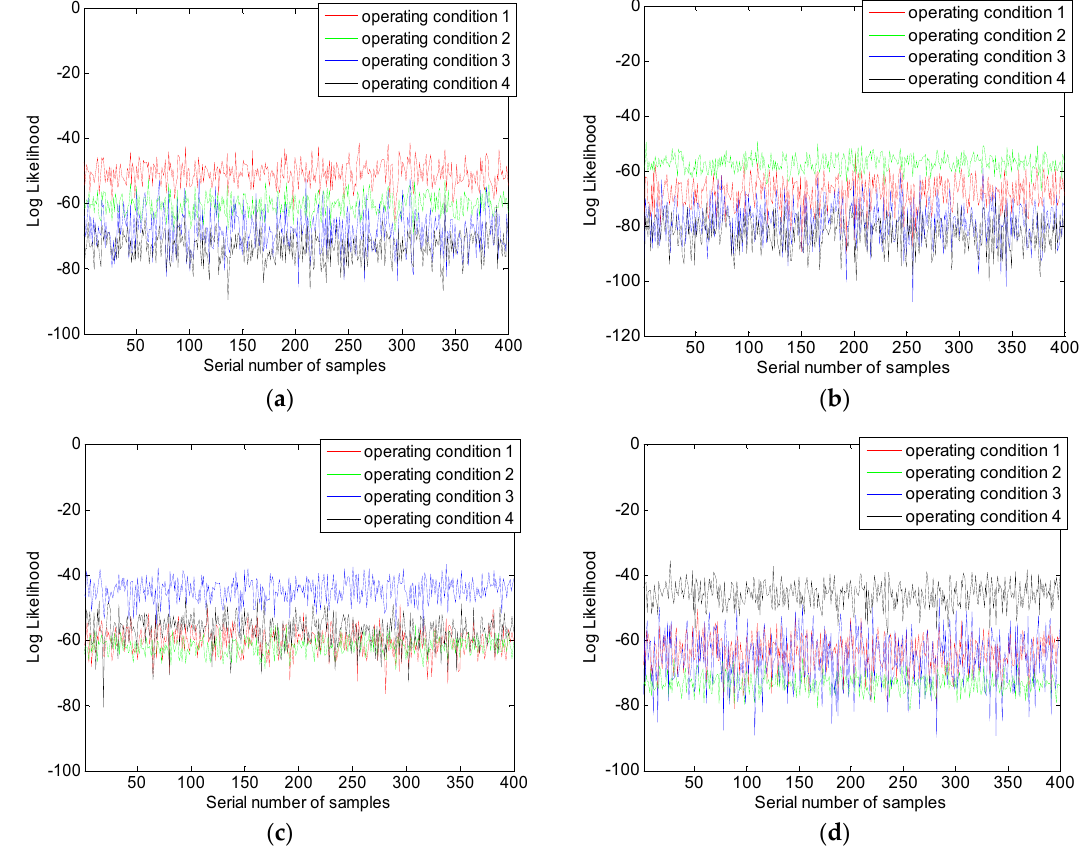
Figure 14. Classification results of the method: ( a ) Model 1; ( b ) Model 2; ( c ) Model 3; and, ( d ) Model 4. Table 5. Confusion matrix of the Table 4. Average Log likelihood outputted by models.